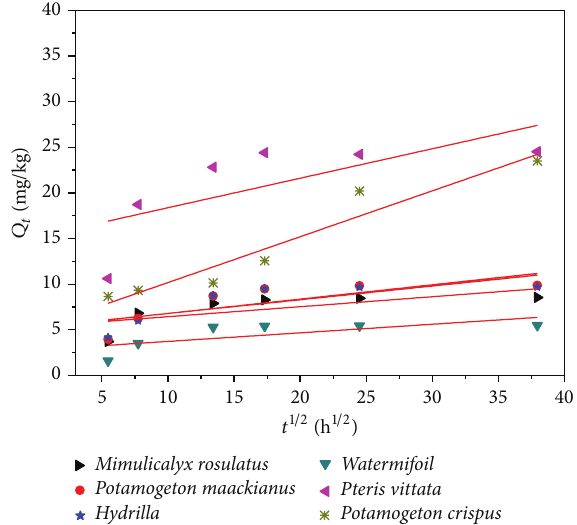
Figure 6: The linearized intraparticle diffusion model for the removal of As (III) ( 𝑇 = 13 ∘ C, initial As (III) concentration = 1.000